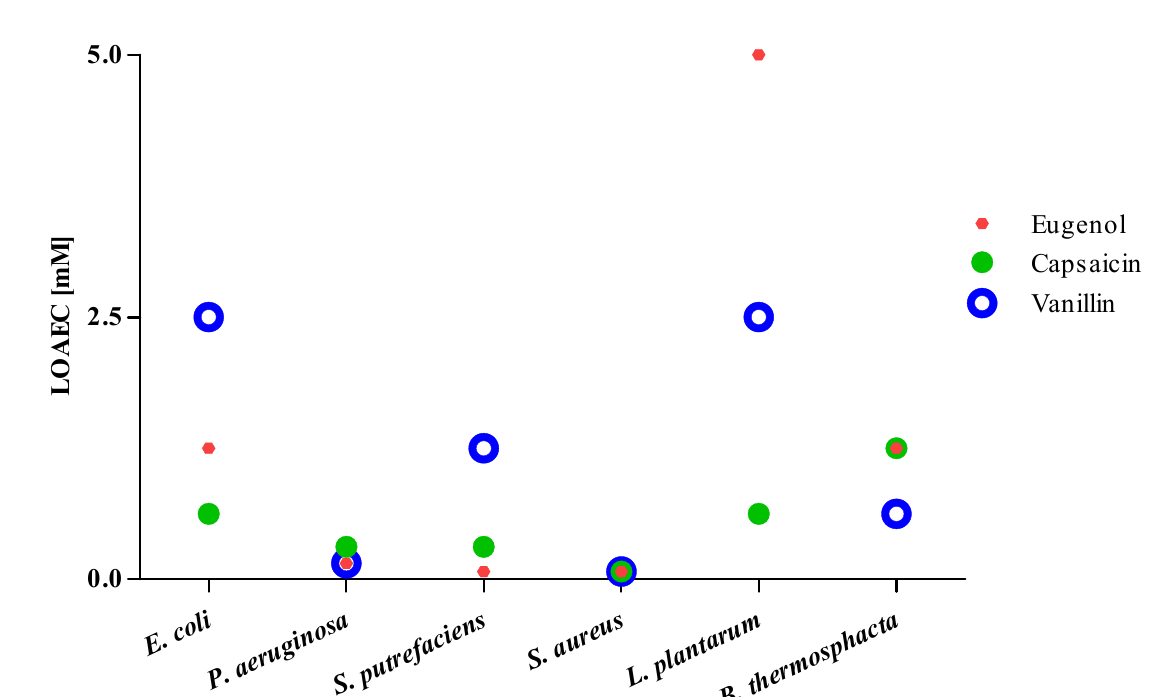
Figure 2. Lowest observed adverse effect concentration (LOAEC) values. LOAEC values [mM] after 24 h exposure (one-way ANOVA, Dunnett’s test of eugenol, capsaicin, and vanillin on the strains tested in the microbial susceptibility test).